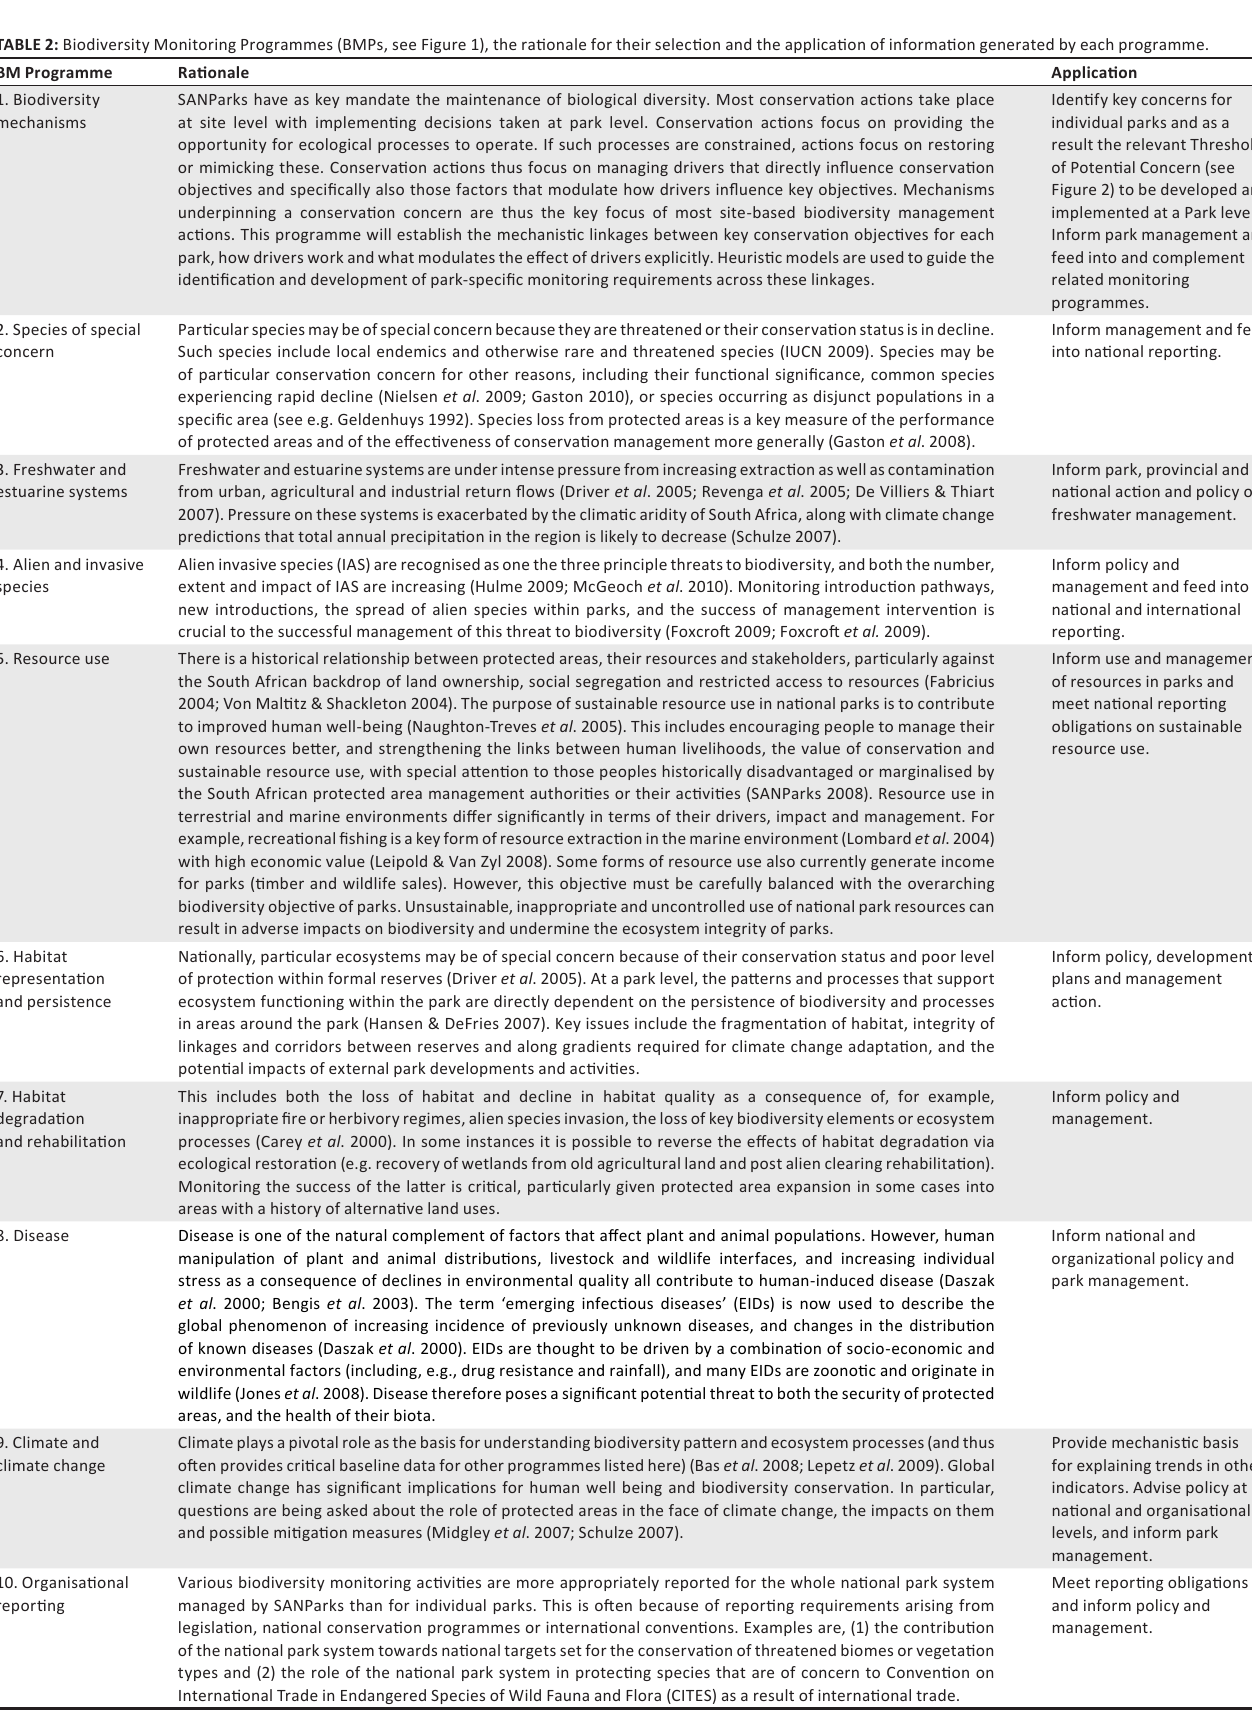
TABLE 2: Biodiversity Monitoring Programmes (BMPs, see Figure 1), the rationale for their selection and the application of information generated by each